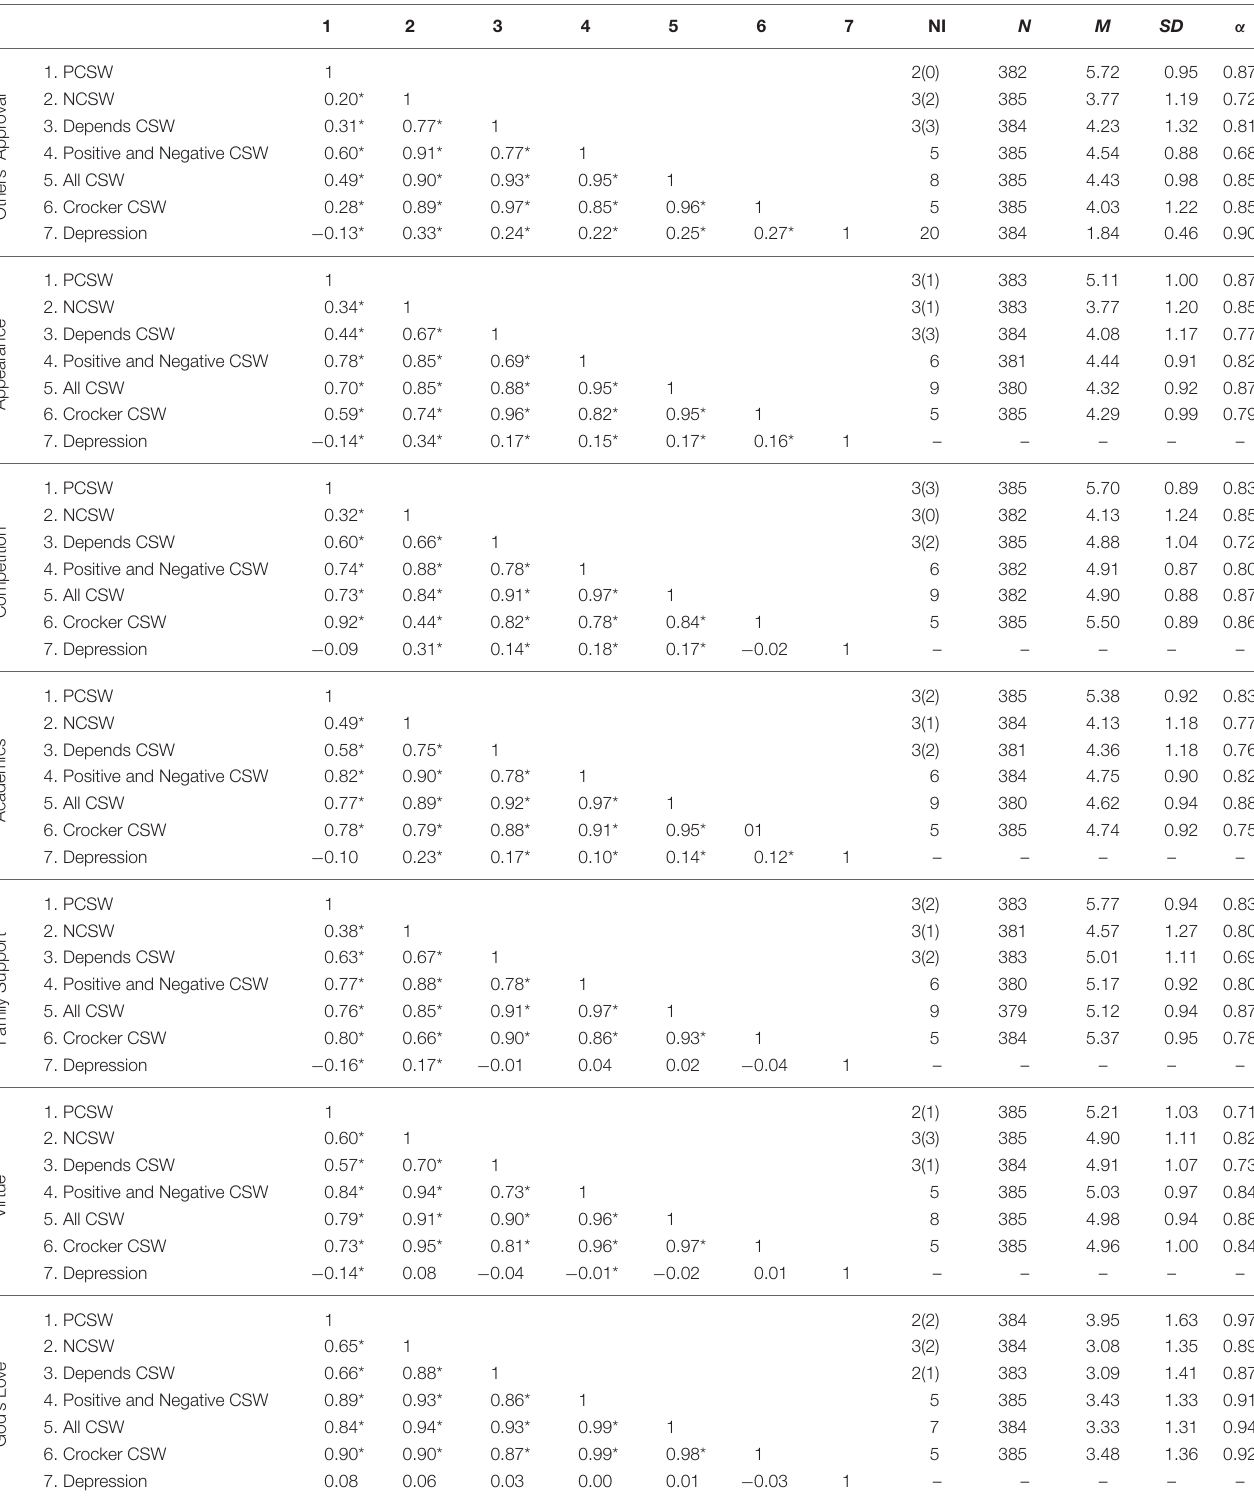
TABLE 1 | Descriptive Statistics, Internal Consistencies ( α ), and Intercorrelations for All the